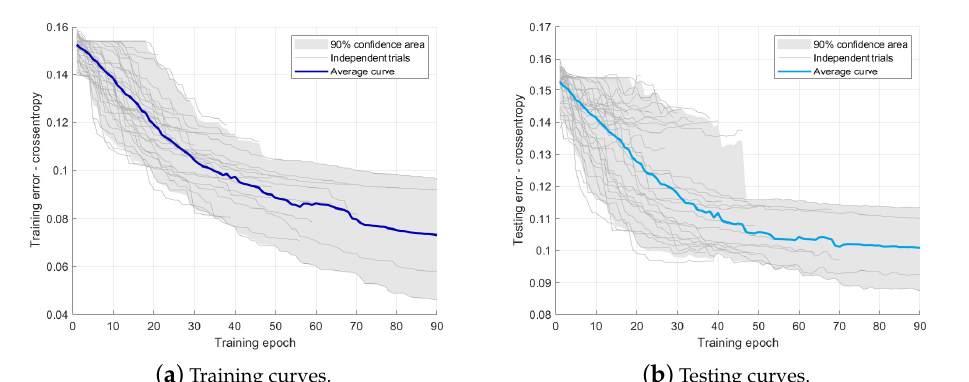
Figure 9. Training and testing convergence curves.